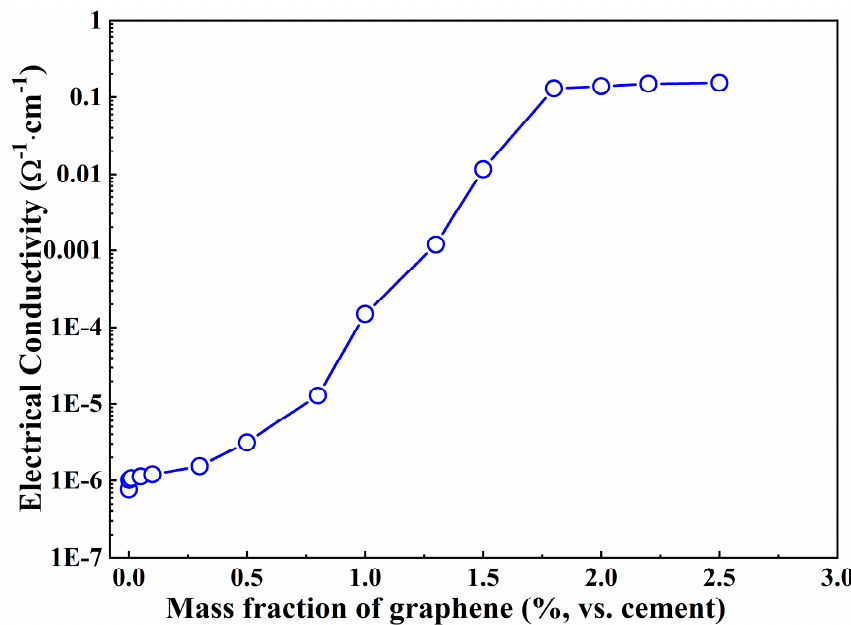
Figure 2. Conductivity vs. graphene content for graphene/cement composites obtained by DC meas- urement.